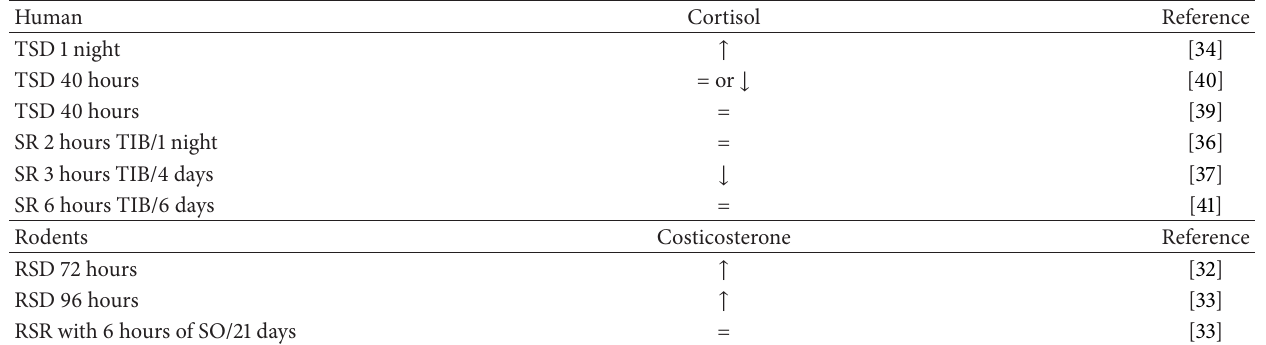
Table 1: Differential effect of sleep loss time upon glucocorticoid